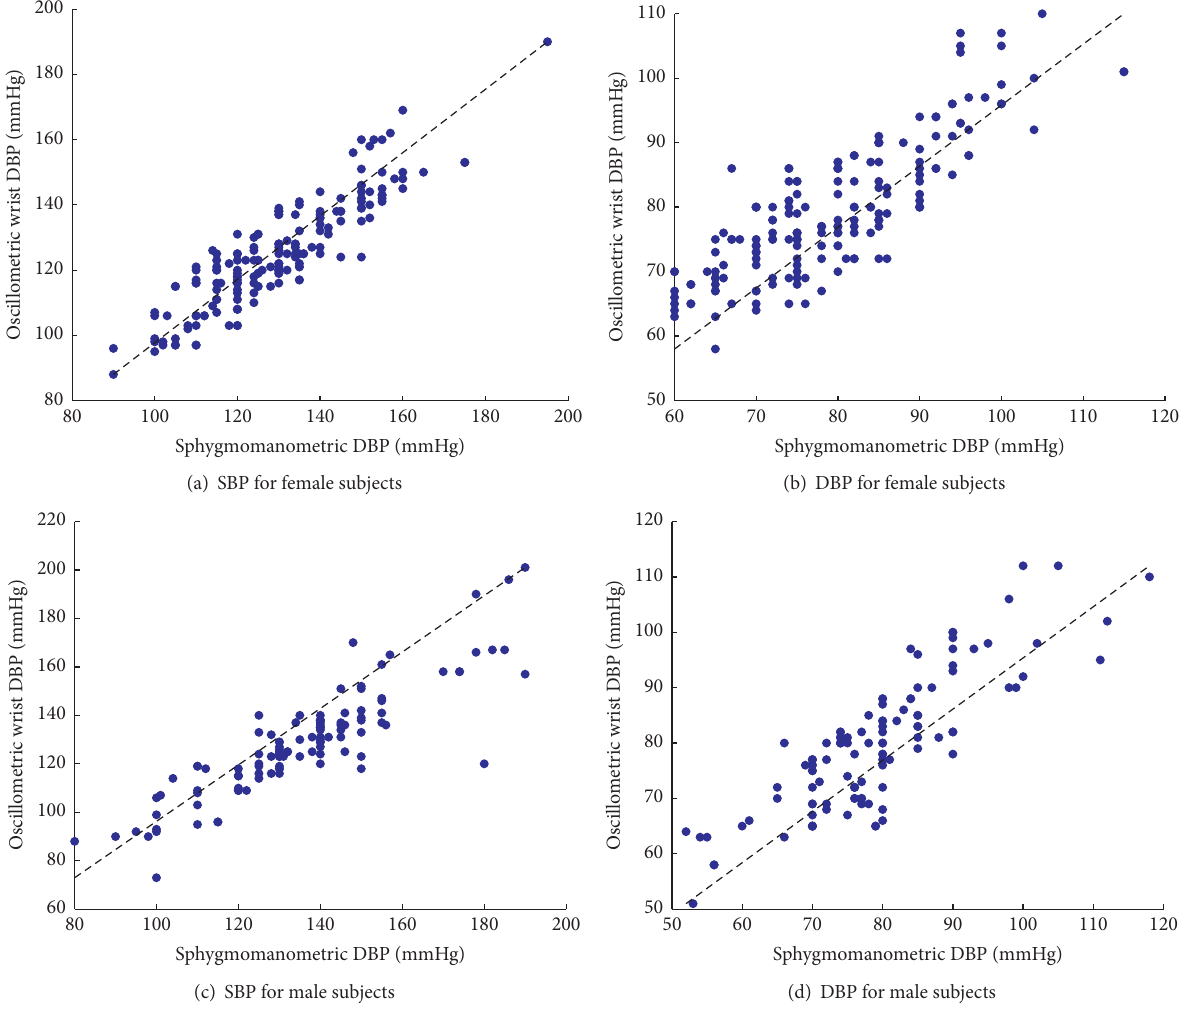
Figure 9: Scatter plot of of wrist sensor on that of sphygmomanometric